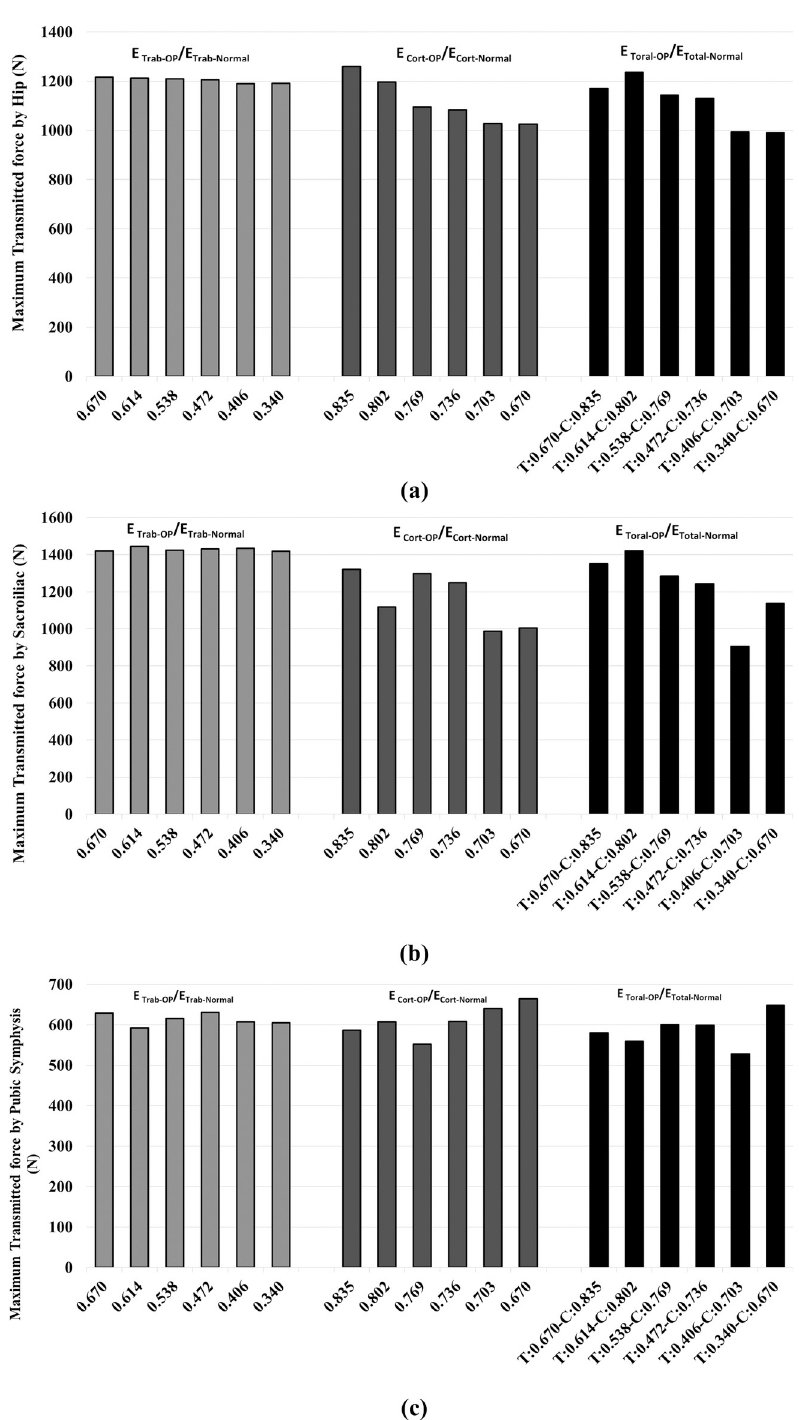
Fig 8. Effect of reduction in trabecular (E Trab ), cortical (E cort ), and total (E Total ) elastic on the transmitted load (contact force) by a) hip, b) sacroiliac, and c) pubic symphysis.